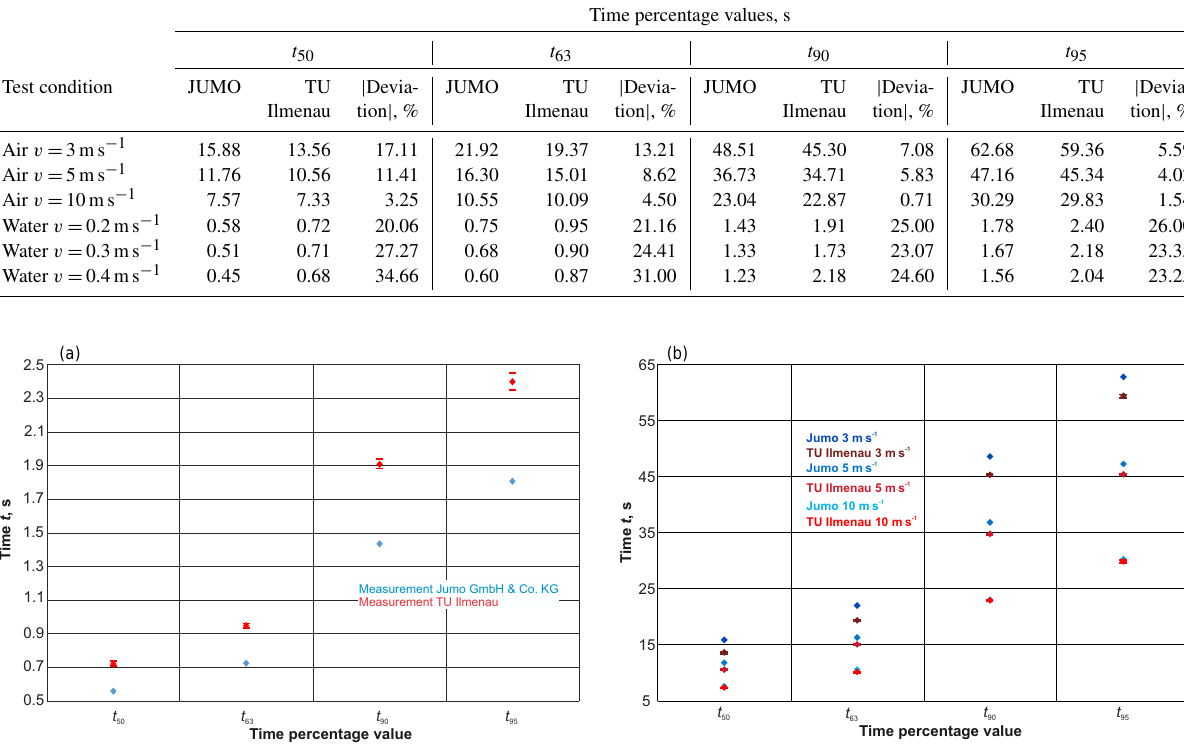
Figure 8. (a) Comparison of the time percentage values for measurements in water v = 0.2ms − 1 . (b) Comparison of the time percentage values for measurements in air at different flow